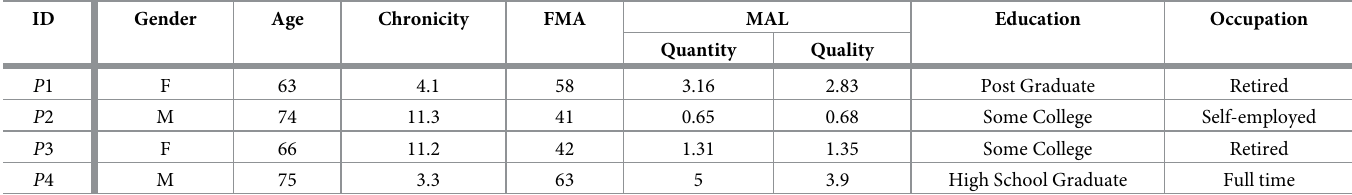
Table 1. The demographic and clinical information of the stroke